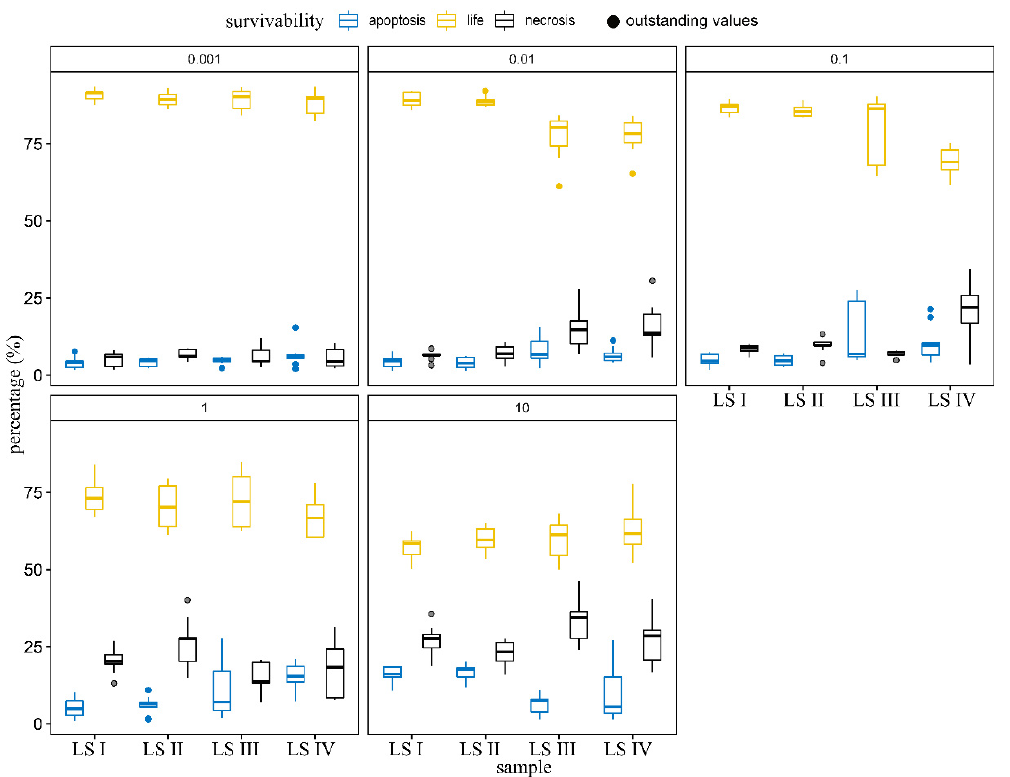
Figure 3. Cell viability assay of tested soaps (LS I—base; in following soaps addition of 4% ( w/w ) surfactants: LS II—cocamidopropyl betaine; LS III—addition of cocamidopropyl hydroxysultaine;